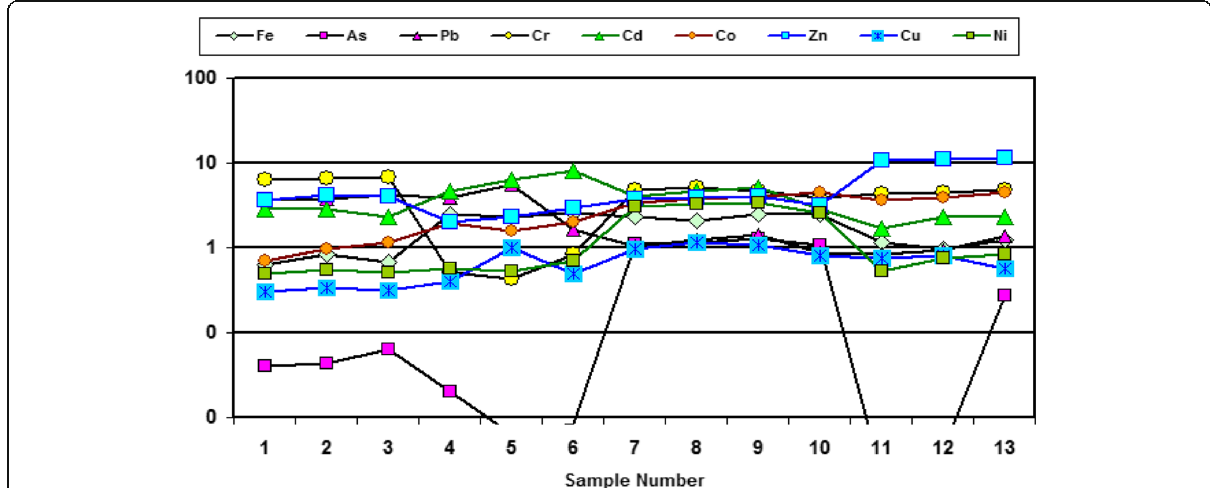
Fig. 4 Contamination factor of the heavy metals of the studied samples